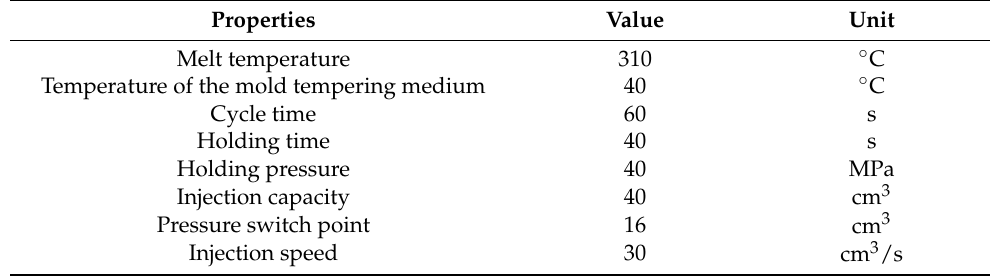
Table 3. Technological conditions for the injection of samples into the recycled